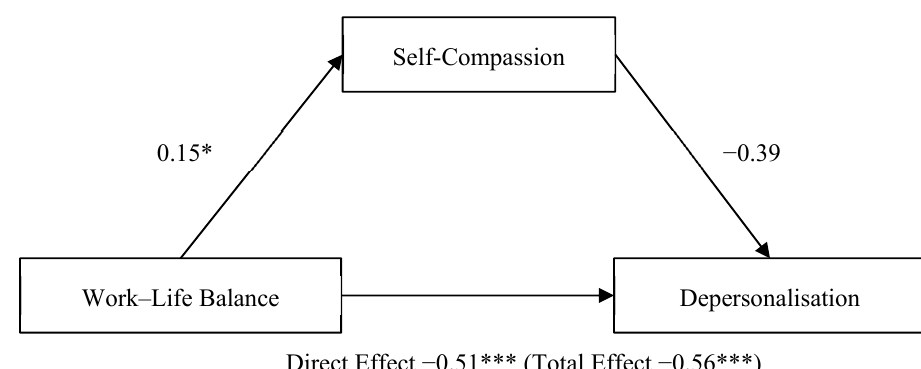
Figure 2. Parallel mediation model: work–life balance as a predictor of depersonalisation, mediated by self-compassion. * p < 0.05; *** p < 0.001.